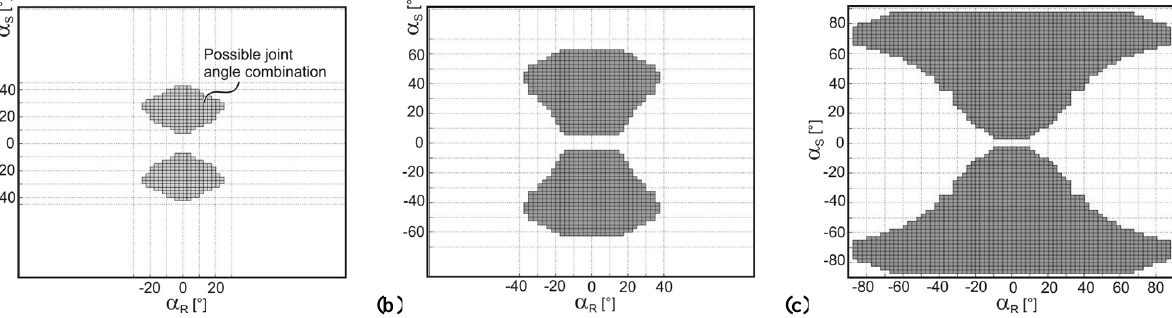
Figure 10. Successful passive alignment of the contact element for (a) linear motion ( µ = 0 . 2), circular motion ( µ = 0 . 2) (b) and circular motion and contact modification ( µ = 0 . 6) (c) while grasping.